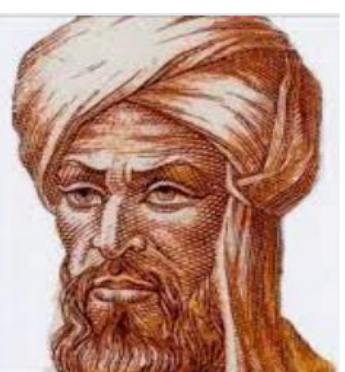
Figure 25. Khwarizmi.